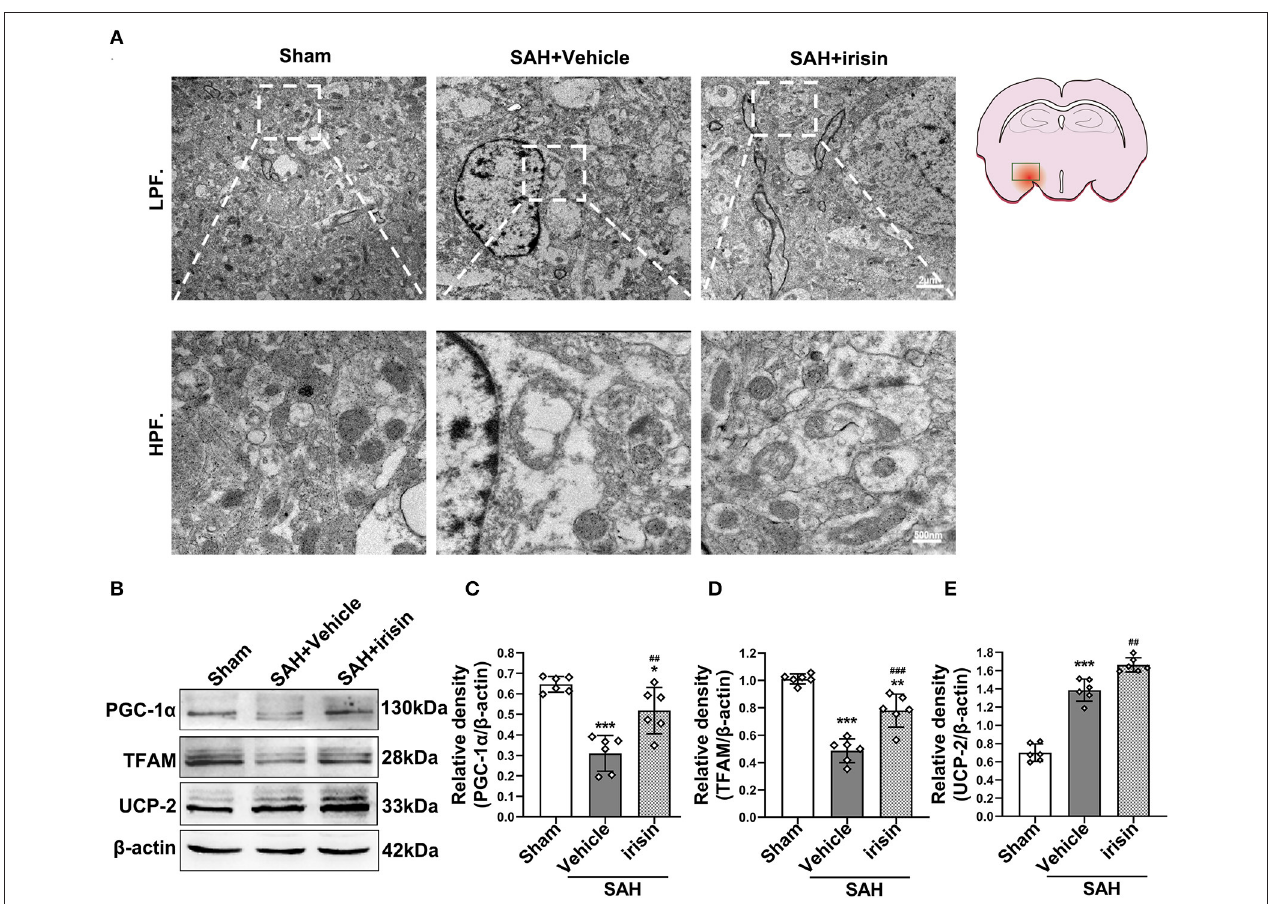
FIGURE 6 | Effect of exogenous irisin treatment on mitochondrial morphology and mitochondrial biogenesis in mice brain 24h after SAH. (A) Less mitochondrial swelling and vacuolization were observed under the TEM after irisin treatment, Scale bar = 2 µ m, 500nm, n = 3 for each group. (B–E) Representative western blotting images and relative density analysis of TFAM, PGC-1 α , and UCP-2 24h after SAH. Exogenous irisin treatment significantly improved the expressions of TFAM and PGC-1 α . The UCP-2 expression increased after SAH and a higher level was observed after irisin treatment, n = 6 for each group. All data were presented as mean ± SD. The one-way ANOVA was used followed by the Tukey’s HSD post-hoc test and the Holm–Bonferroni correction method. * P < 0.05, ** P < 0.01, *** P < 0.001 vs. Sham group; ## P < 0.01, ### P < 0.001 vs. SAH + Vehicle group. Vehicle group, sterile 0.9% of NaCl; UCP-2, Uncoupling Protein-2; SAH, subarachnoid